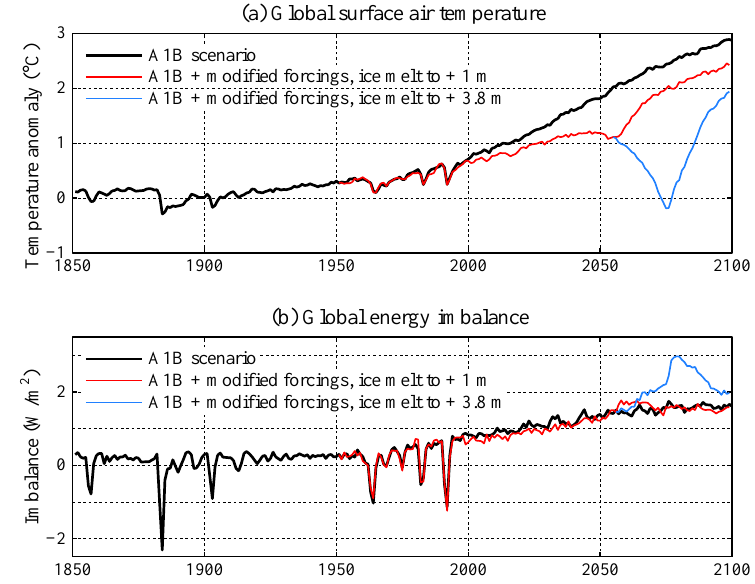
Figure 15. (a) Surface air temperature ( ◦ C) change relative to 1880–1920 and (b) global energy imbalance (Wm − 2 ) for the modified forcing scenario including cases with global ice melt reaching 1 and 3.8m.